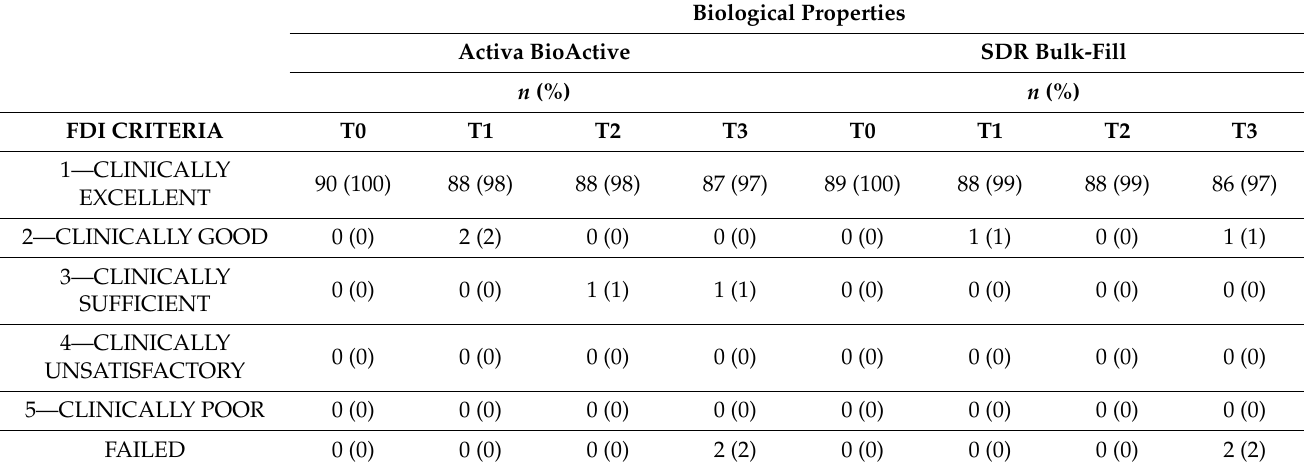
Table 9. Biological properties evaluation based on FDI criteria.